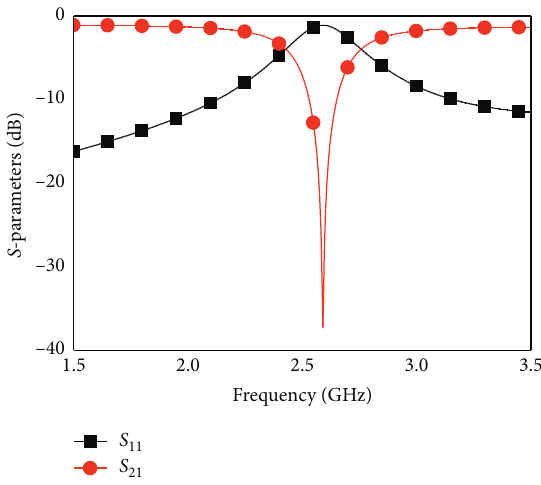
Figure 5: Scattering parameters of a SRR unit